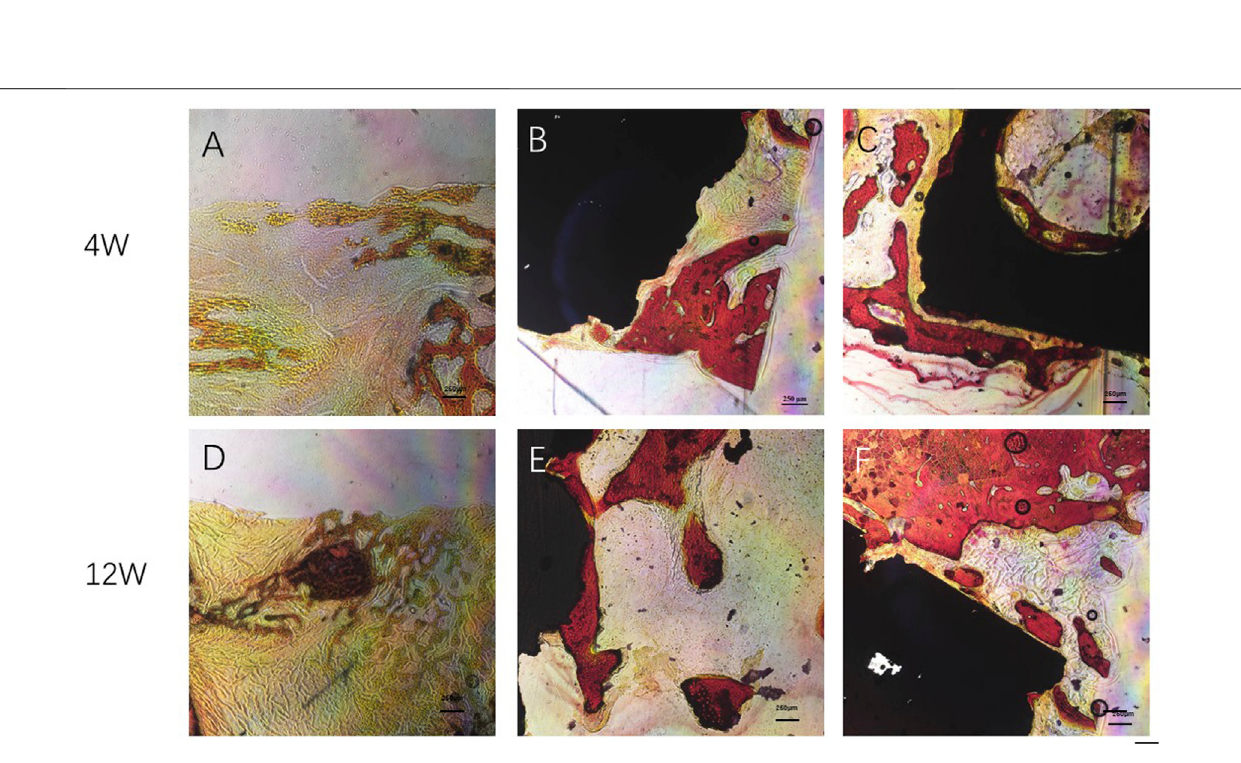
Frontiers in Bioengineering and Biotechnology |